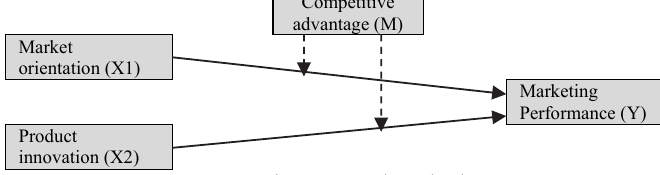
Fig. The proposed